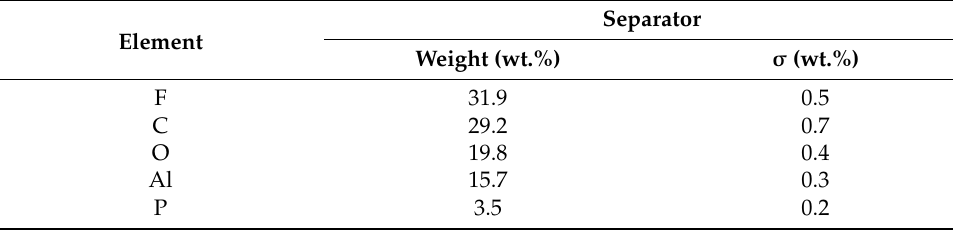
Table 4. Results of the EDS element map for the battery separator. Element